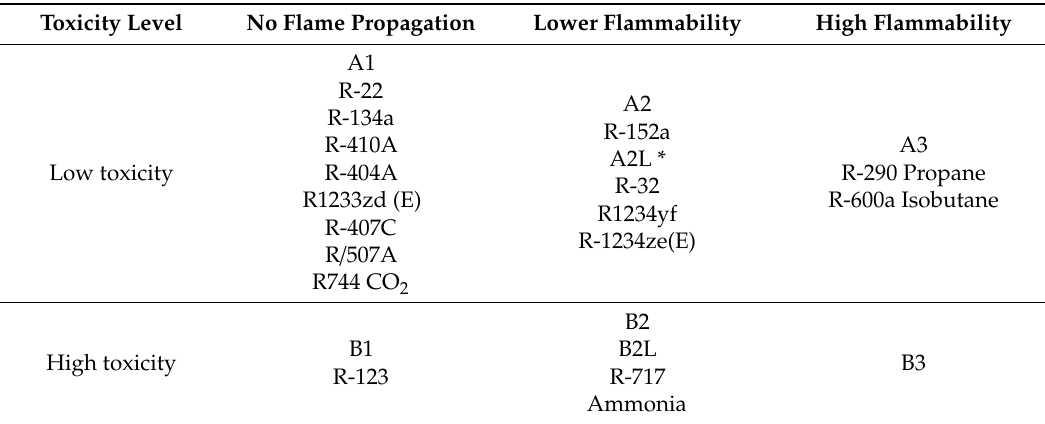
Table 2. Flammability and toxicity classifications of refrigerants